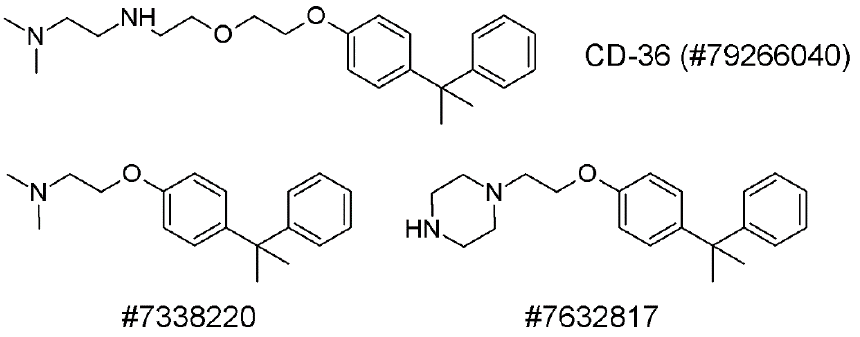
Figure 3. CB-36 and its analogues. The numbers are ChemBridge database identifiers.